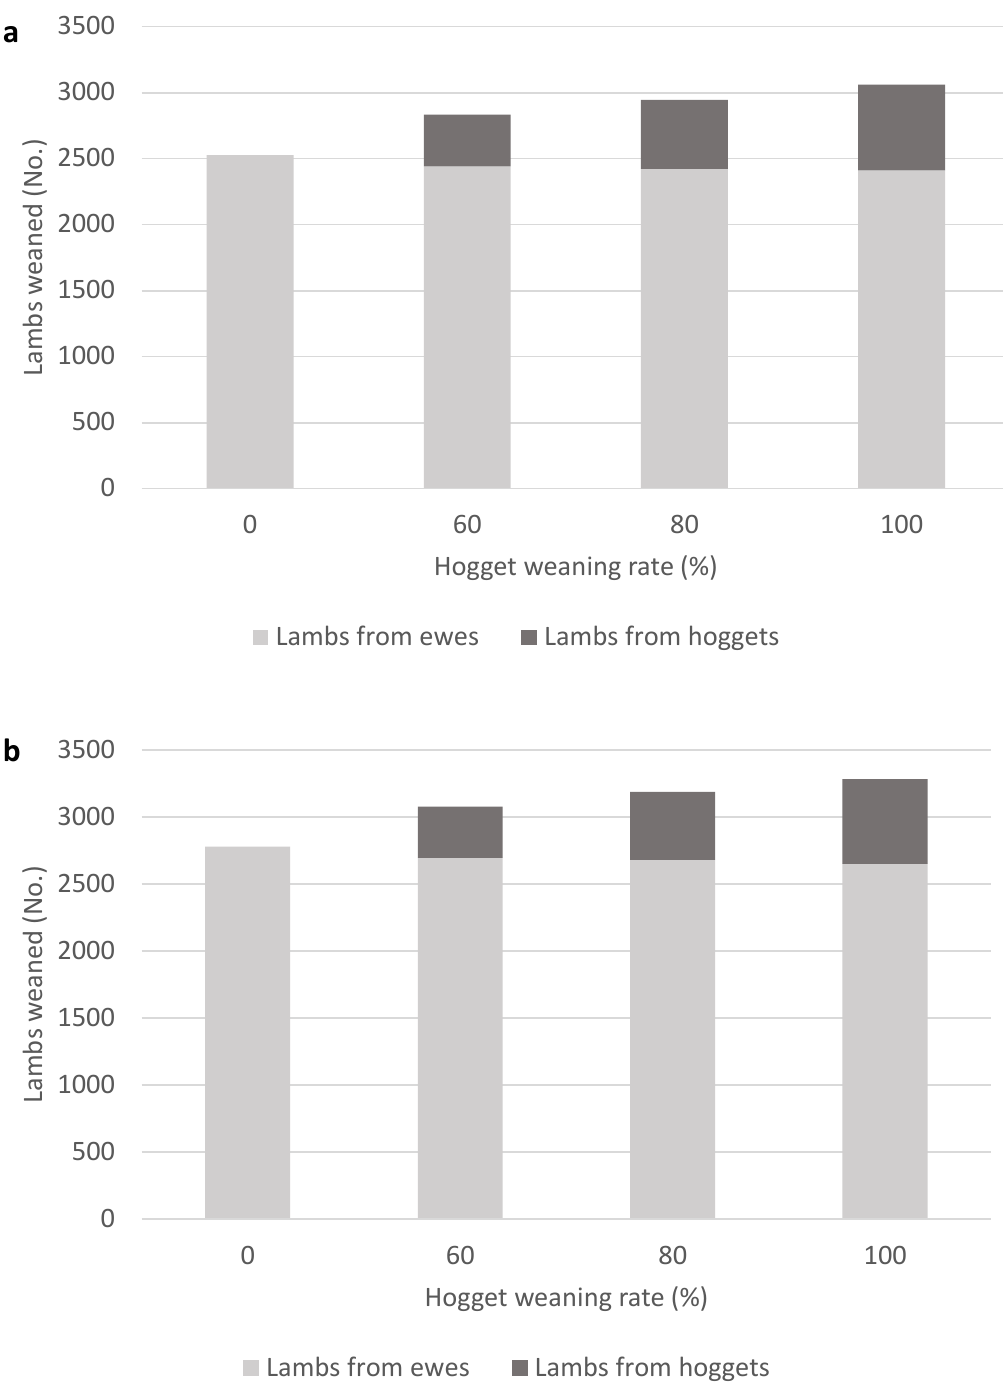
Figure 3. Numbers of lambs weaned from mature ewes (from ewes aged two to six years) and hoggets, with varying hogget weaning rates and with mature ewe weaning rates of ( a ) 132% and ( b ) 150%.